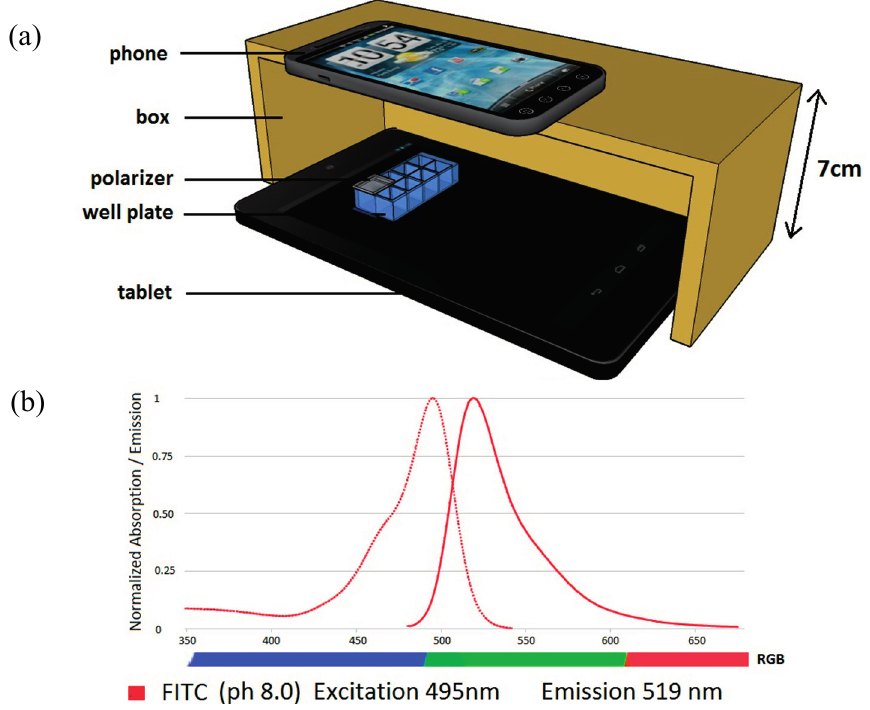
Figure 1. ( a ) Schematic diagram of the device cross-section; ( b ) Excitation and emission spectra of fluorescein in comparison to a typical RGB colour